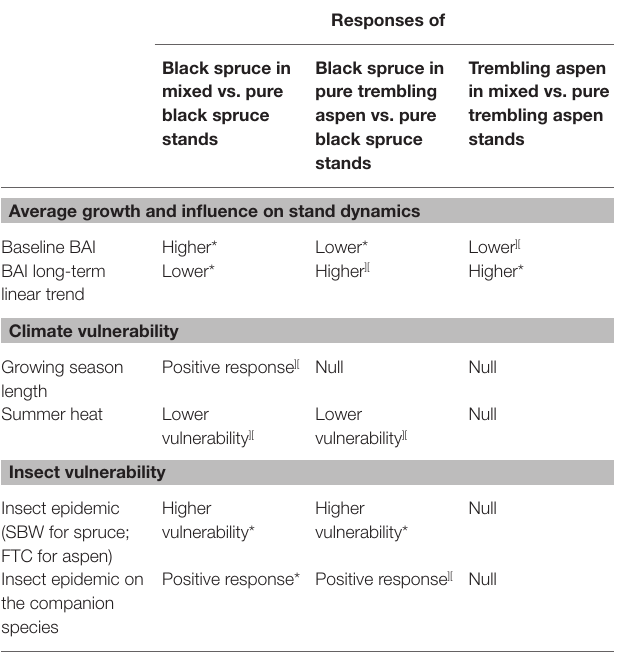
TABLE 3 | Summary of the effects of species mixture on responses of black spruce and trembling aspen based on the results of the linear Bayesian models ( Figure 5 ). Responses of